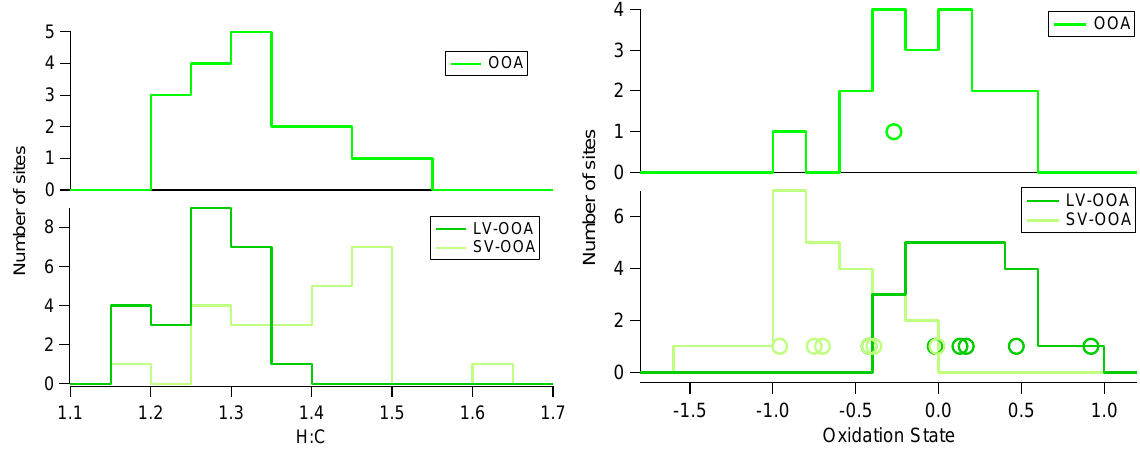
Fig. 5. (a) Histogram showing the distribution of the estimated H:C ratios observed across multiple sites. (b) Histogram showing the distribution of the estimated oxidation states (OS C ≈ 2 O/C − H/C) observed across multiple sites. The open circles are HR-AMS ambient data in which oxidation state are directly calculated from the